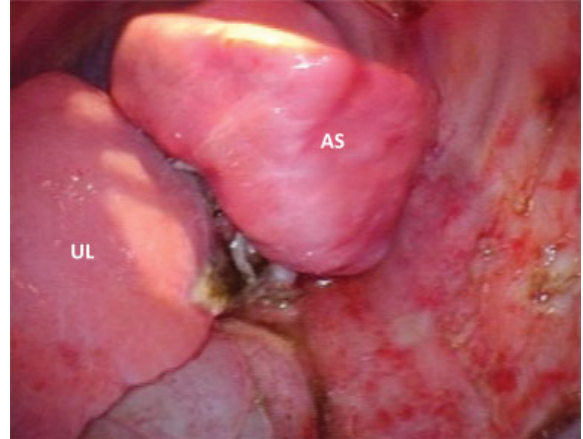
Fig. 4 Thoracoscopic view after basal segmentectomy showing preservedhealthy apical segment. AS, apical segment; UL,